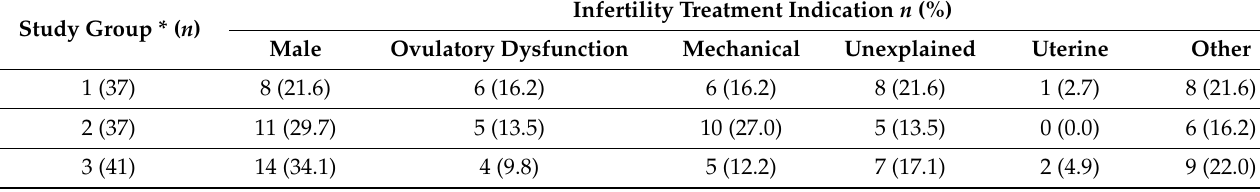
Table A1. Indications for infertility